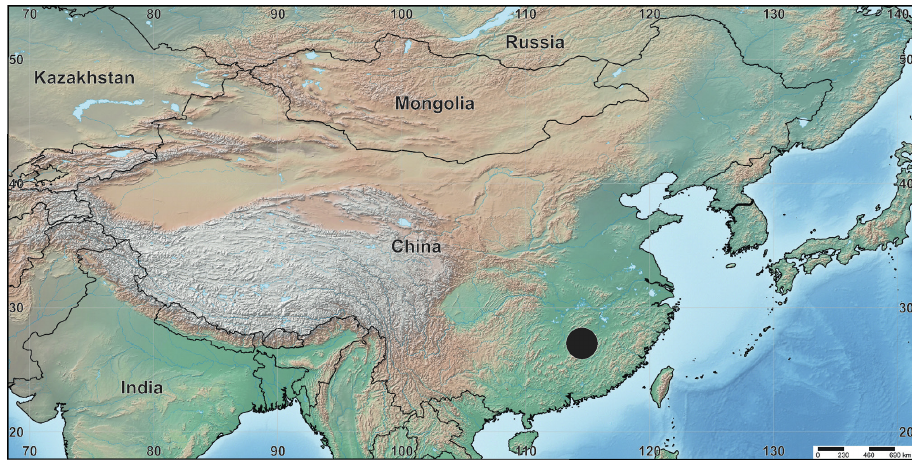
Figure 17. The location of the Jinggang Mountain National Nature Reserve in China indicated by a large black dot. Table 1. List of Thomisidae species recorded in Jinggang Mountain National Nature Reserve. Genera recorded for the first time are marked with an asterisk (*).